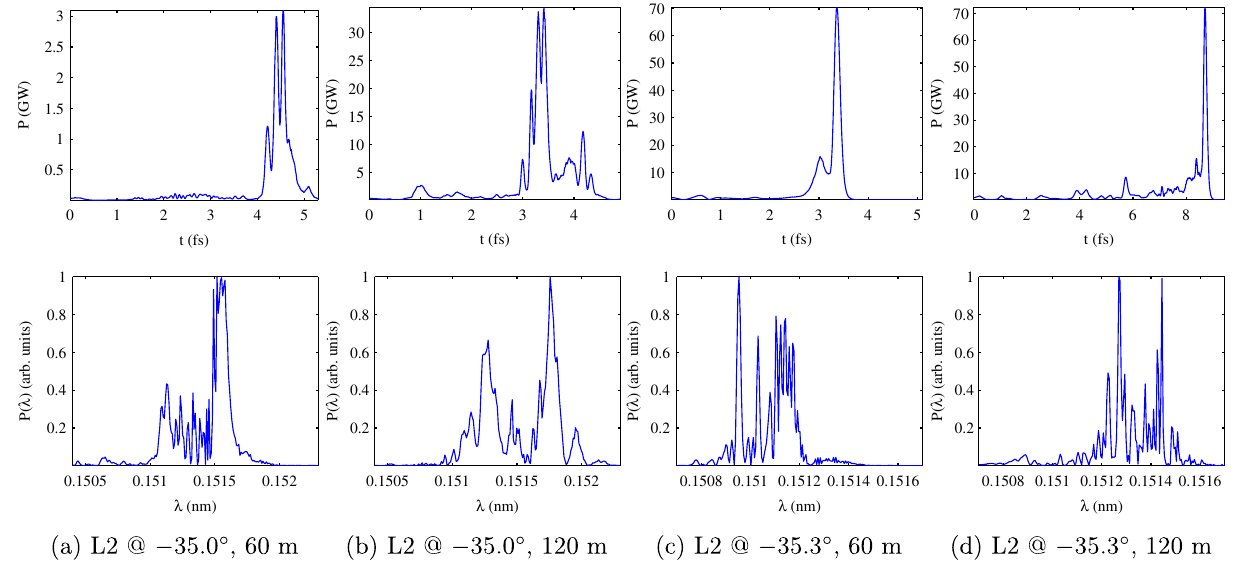
FIG. 6. Simulation results of the FEL power profile (upper) and spectrum (lower) at different locations in the undulator using the electron beam with the L2 rf phase at − 35 . 0 ° for (a) and (b) and the L2 rf phase at − 35 . 3 ° for (c) and (d). No undulator taper is applied. In the time-domain x-ray power profiles, the pulse head is to the right in these plots and